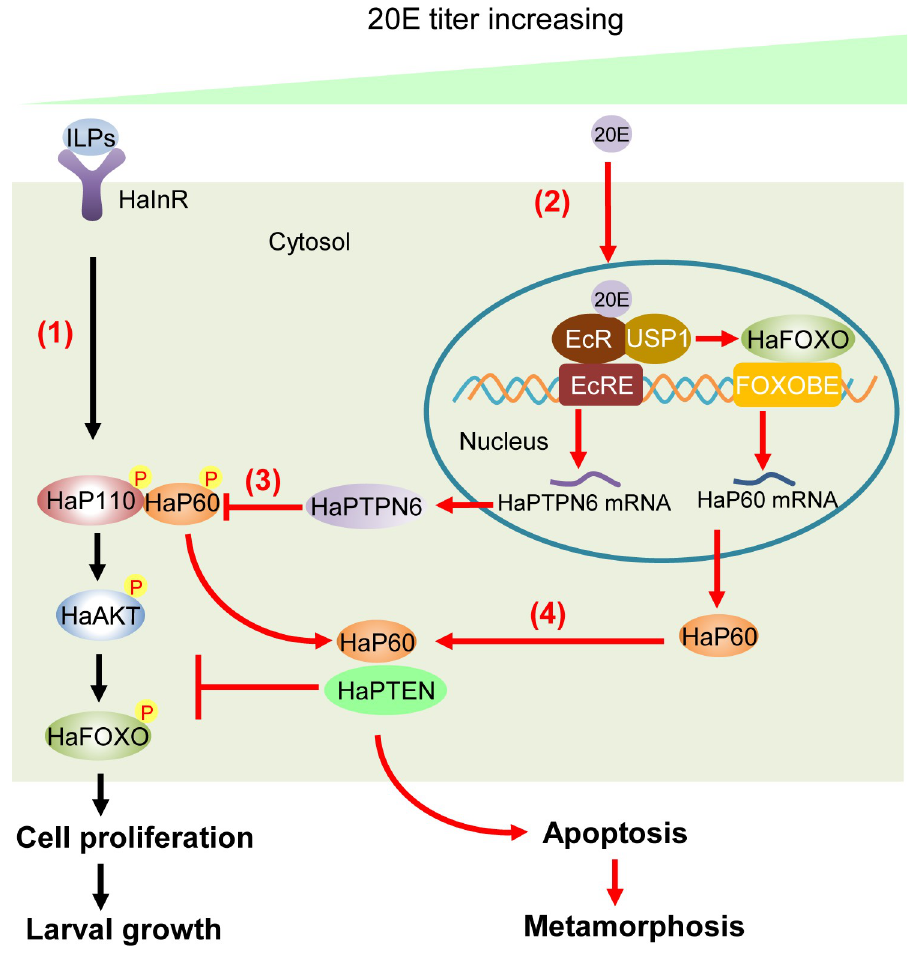
Fig 10. Chart interpreting the dual functions of HaP60 in the IIS and 20E pathways by changing its phosphorylation status and the consequence. (1). HaP60 plays a key role in the IIS as a phosphorylated form to mediate translocation of HaP110 to the cell membrane and HaAKT and HaFOXO phosphorylation to arrest HaFOXO in the cytosol to allow cell proliferation and larval growth. (2 and 3). 20E, via the EcR, upregulates HaPTPN6 expression to dephosphorylate HaP60 and HaP110, therefore blocking IIS. (4). 20E, via the EcR-and HaFOXO- signal axis, upregulates HaP60 expression and mediates the interaction of HaP60 with HaPTEN to further reverse the function of HaP110, resulting in cell apoptosis and